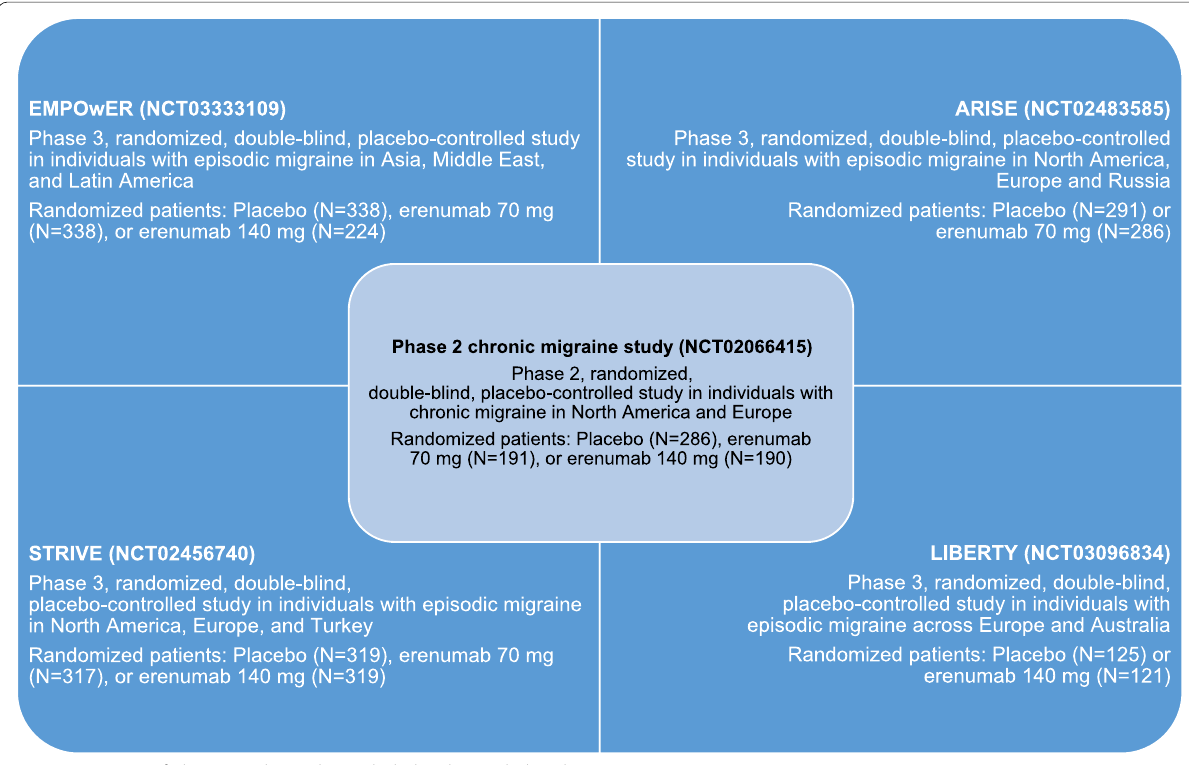
Fig. 1 Summary of phase 2 and 3 studies included in the pooled